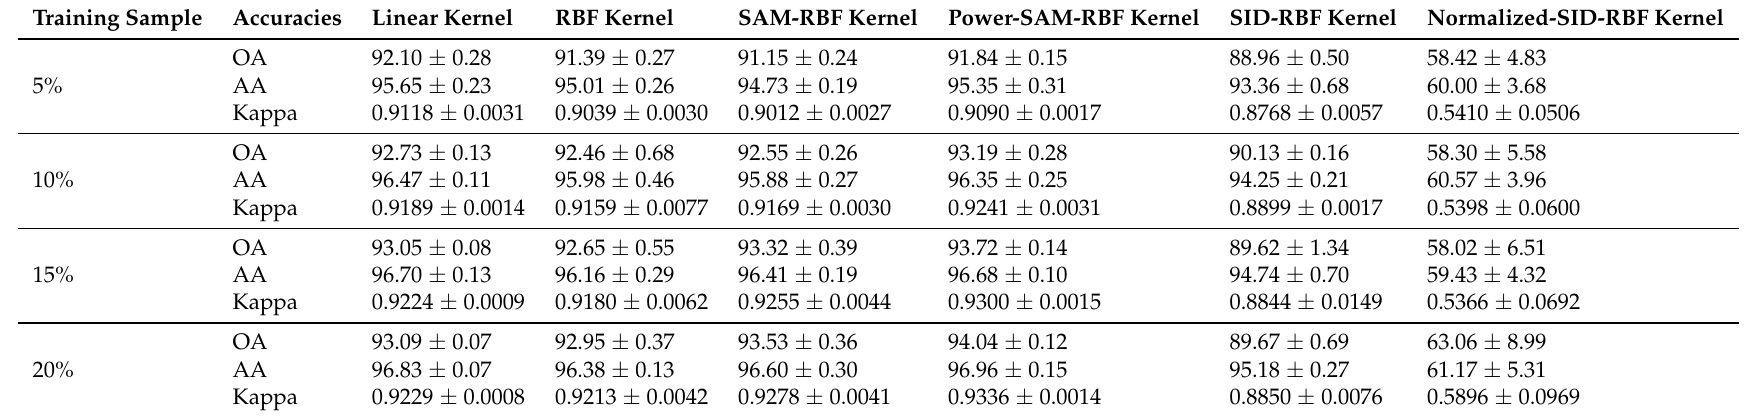
Table 5. OAs, AAs, and kappa coefficients of the Linear, RBF, SAM-RBF, Power-SAM-RBF, SID-RBF, and Normalized-SID-RBF kernels on the Salinas Valley